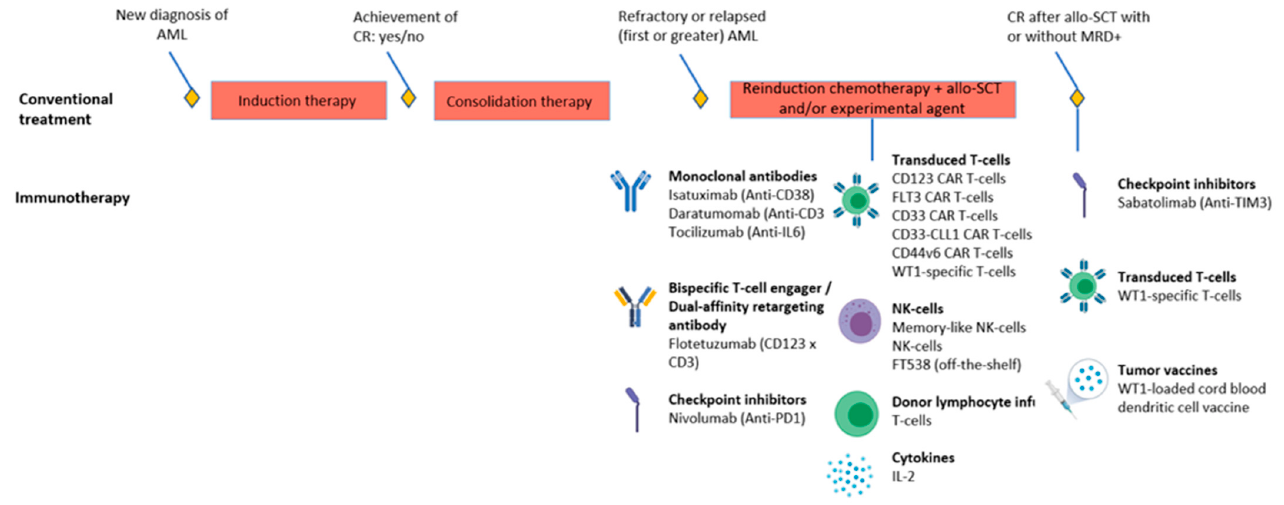
Figure 2. Overview of currently ongoing or planned immunotherapy trials for pediatric AML. Concomitant therapies are presented in Table 2. AML: acute myeloid leukemia; allo-SCT: allogeneic stem cell transplantation; CAR: chimeric antigen receptor;